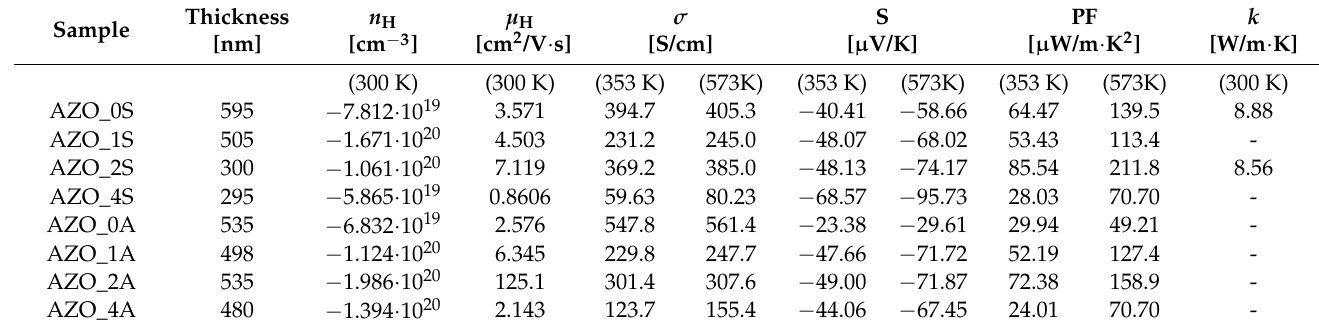
Table 1. Thickness, electrical and thermoelectric properties of the AZO films deposited on silica (series AZO_xS) and on Al 2 O 3 (series AZO_xA) for different concentrations x (%) of SnO 2 dopant. Sample